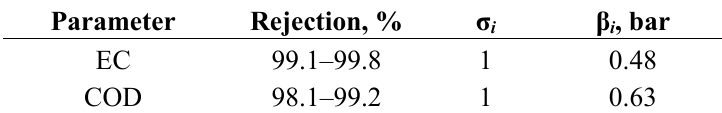
Table 6. Coefficients for electroconductivity (EC) and chemical oxygen demand (COD)